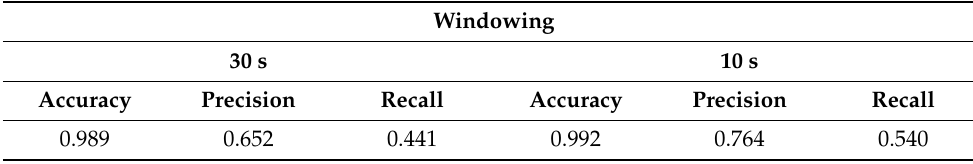
Table 6. Verification results of the proposed model for other